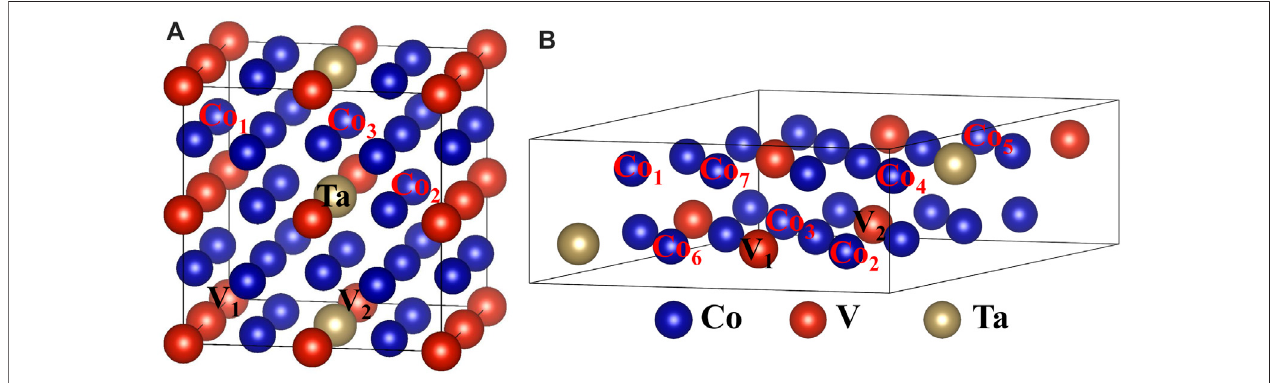
FIGURE 1 | (A) Crystal structure of L1 2 -ordered Co 3 (V, Ta) with six nonequivalent sites (Co 1 , Co 2 , Co 3 , V 1 , V 2 , and Ta) for the substitution by TM elements. (B) Crystal structure of D0 19 -ordered Co 3 (V, Ta) with 10 nonequivalent sites (Co 1 , Co 2 , Co 3 , Co 4 , Co 5 , Co 6 , Co 7 , V 1 , V 2 , and Ta) for the substitution by TM